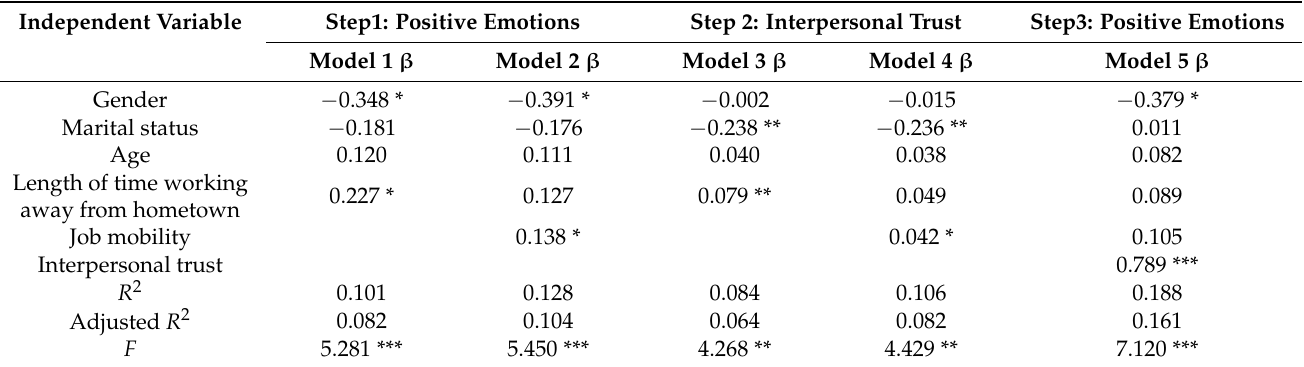
Table 4. Multivariate hierarchical regression analysis of the impact of interpersonal trust and job mobility on positive emotions ( n =